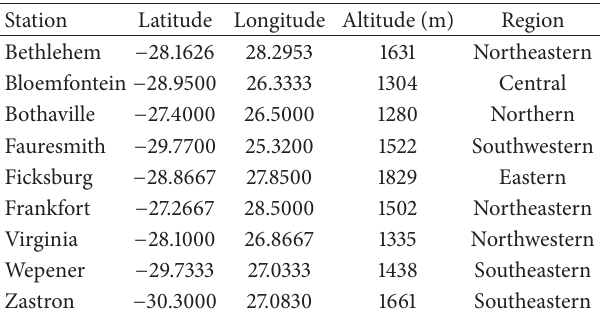
Table 1: Information for climate stations in Free State province used in the frost assessment